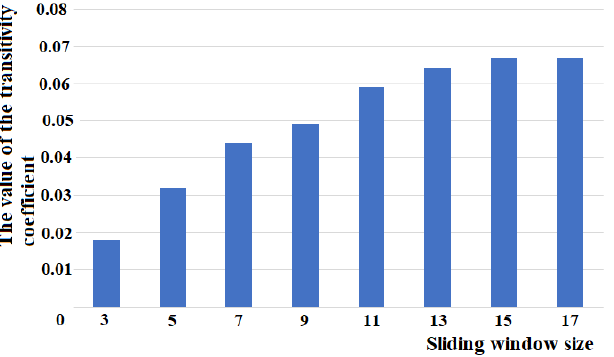
Figure 3. Histogram of the dependence of the graph node transitivity coefficient averaged over the entire network on the value of the sliding window.